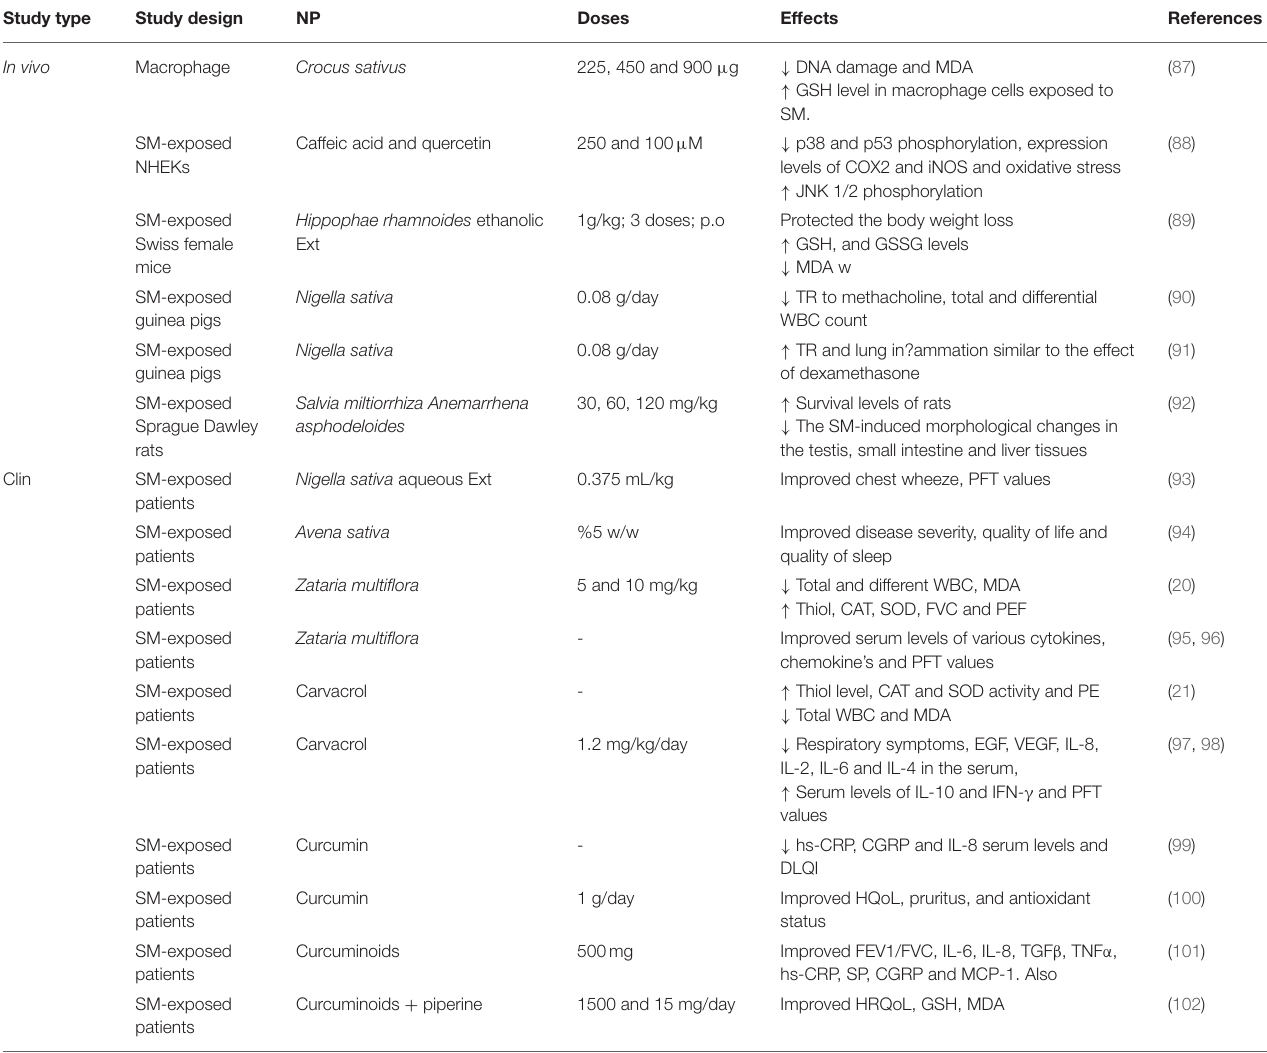
TABLE 6 | The possible therapeutic effects of medicinal plants and their derivatives in the SM-induced lung injuries. Study